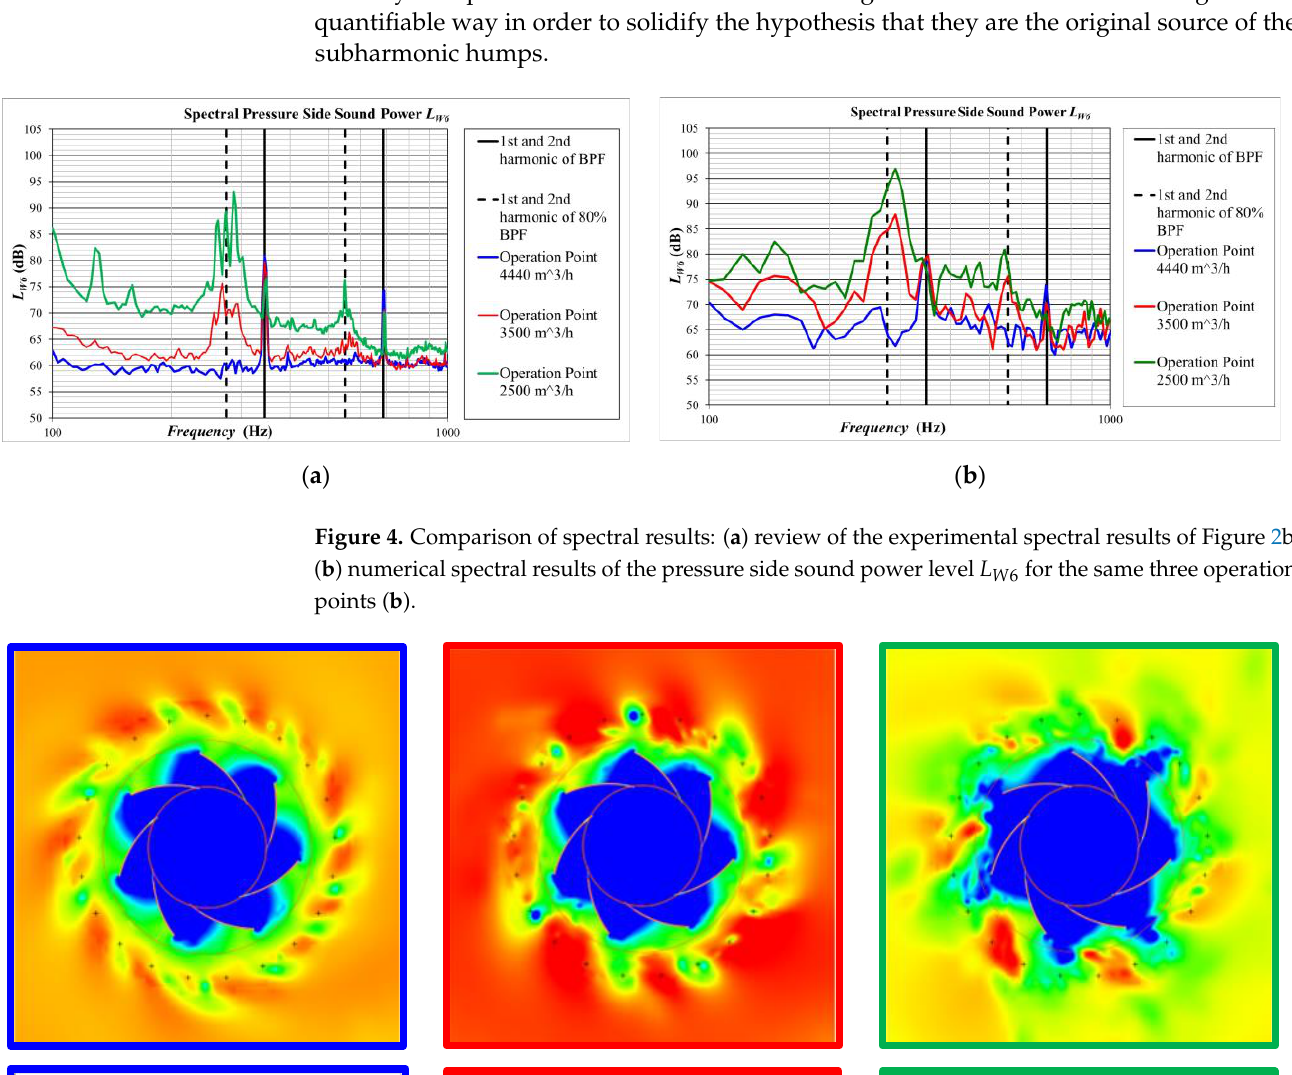
Figure 4. Comparison of spectral results: ( a ) review of the experimental spectral results of Figure 2b; ( b ) numerical spectral results of the pressure side sound power level L W 6 for the same three operation points ( b ).